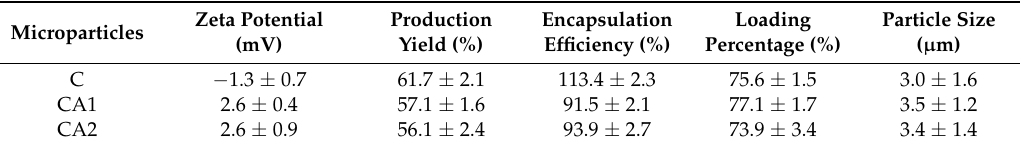
Table 3. Quality evaluation of non-modified microparticles C and cross-linked microparticles CA1 and CA2 containing MF.